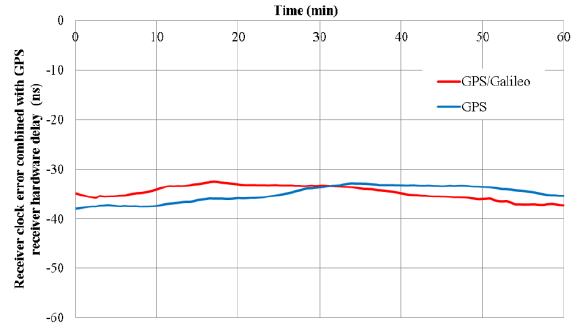
Figure 2. Combined receiver clock error and GPS receiver hardware